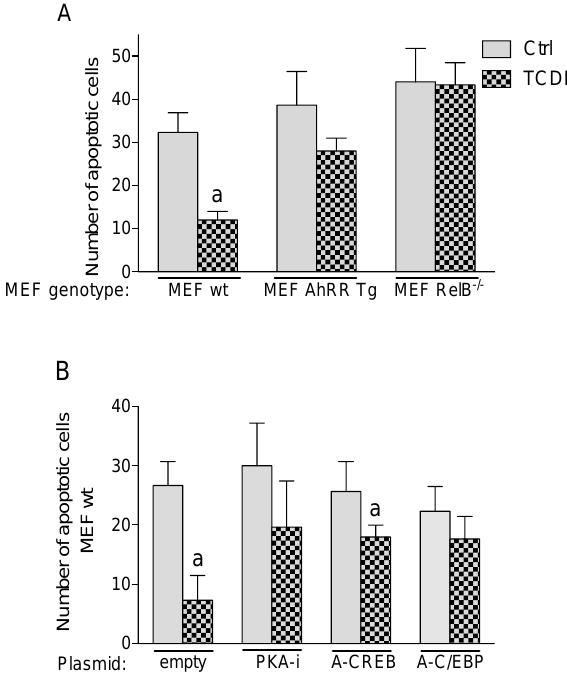
Figure 7. TCDD-mediated apoptotic resistance in MEF. ( A ) MEF derived from wt, AhRR Tg, and RelB − / − mice were treated with 1 nM TCDD for 24 h. Apoptosis was induced by UV light and the number of apoptotic cells was counted after 4 h. ( B ) MEF wt were transfected with dominant negative expression vectors PKA-i, A-CREB and A-C/EBP for 16 h followed by treatment with 1 nM TCDD for 24 h. Apoptosis was induced by UV light and the number of apoptotic cells was counted after 4 h. Values are averages of duplicates from three independent experiments. a Significantly lower than control p < 0.05.